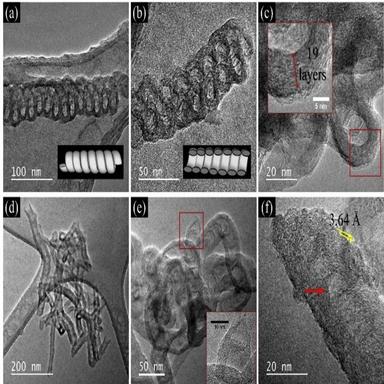
TEM and HRTEM images from S5. (aeb) Helical-tubular carbon nanostructure (c) Cross-section of the helical structure revealing ~19 graphitic layers. (dee) Carbon nanotube with a deformed bamboo shape structure. (f) HRTEM image showing the graphitic layers of carbon nanotubes and deformed bamboo shape structures (red arrow). (A colour version of this figure can be viewed online.)